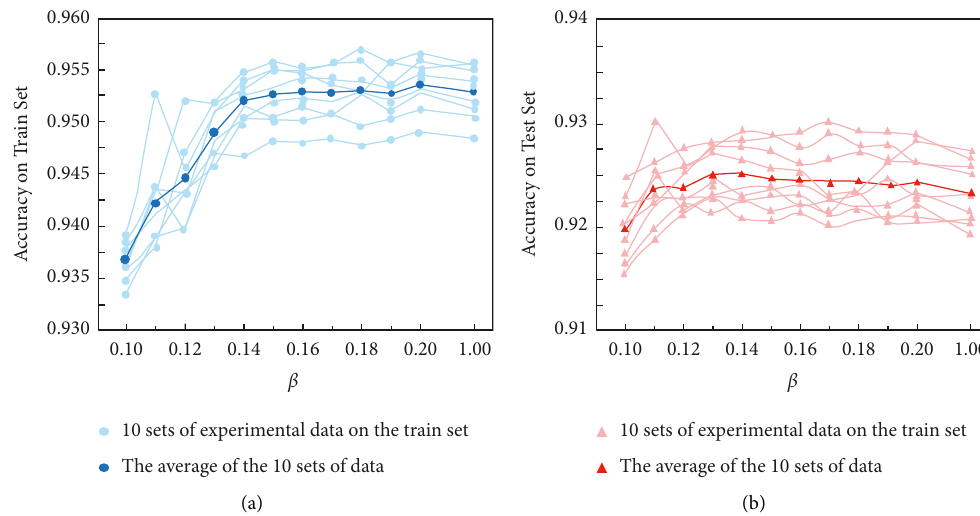
Figure 7: Training learning dictionary performance results graph for different sample numbers. (a) Train set. (b) Test